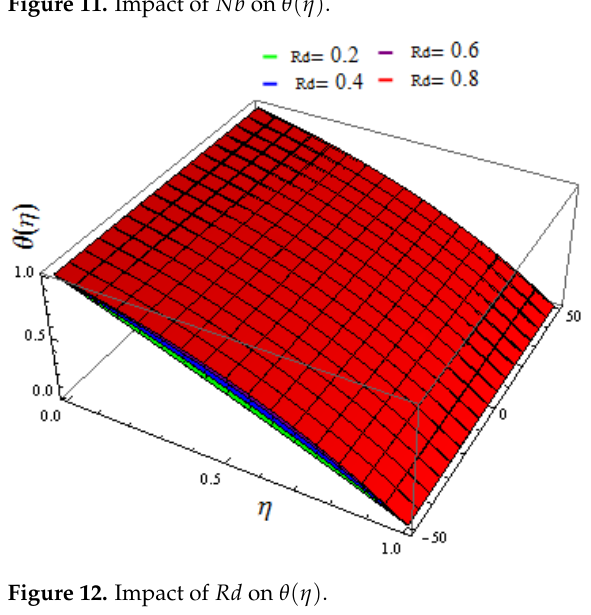
Figure 12. Impact of 𝑅𝑑 on 𝜃(𝜂) . Mathematics 2023 , 11 , x FOR PEER REVIEW Figure 12. Impact of 𝑅𝑑 on 𝜃(𝜂) . Figure 12. Impact of Rd on θ ( η ) .